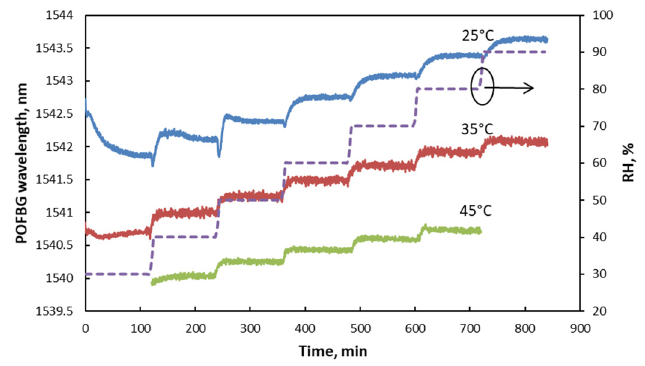
Figure 2. Measured POFBG humidity responses at 25, 35 and 45 °C.